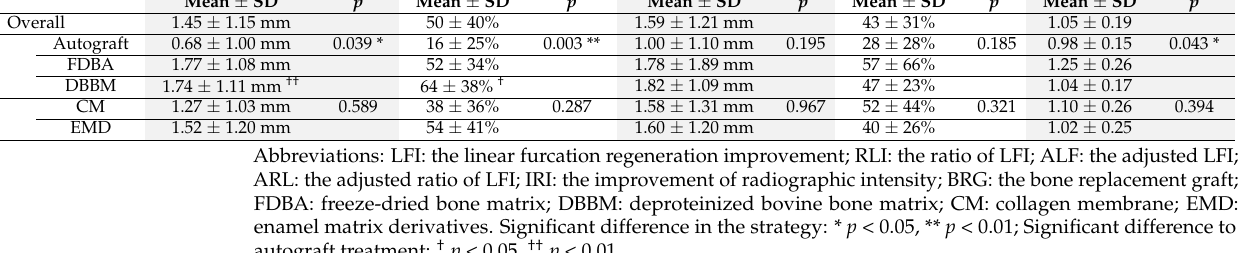
Table 1. The outcome of FDR in the pure furcation defect group based on treatment strategies .